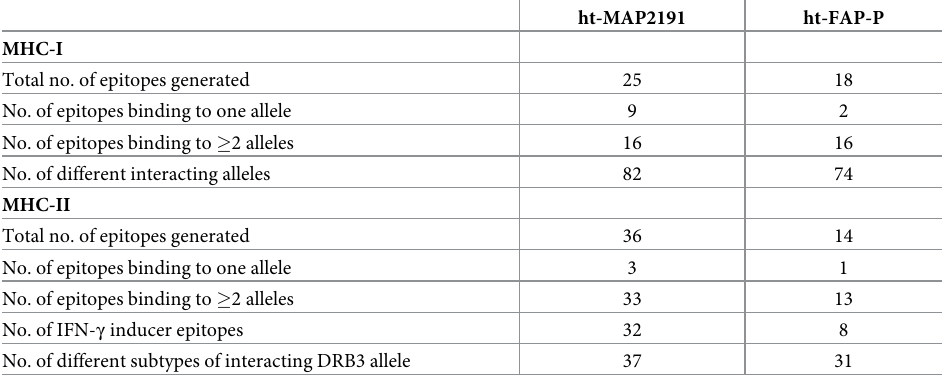
Table 1. Epitopes prediction profile of ht-MAP2191 and ht-FAP-P for MHC- class I and